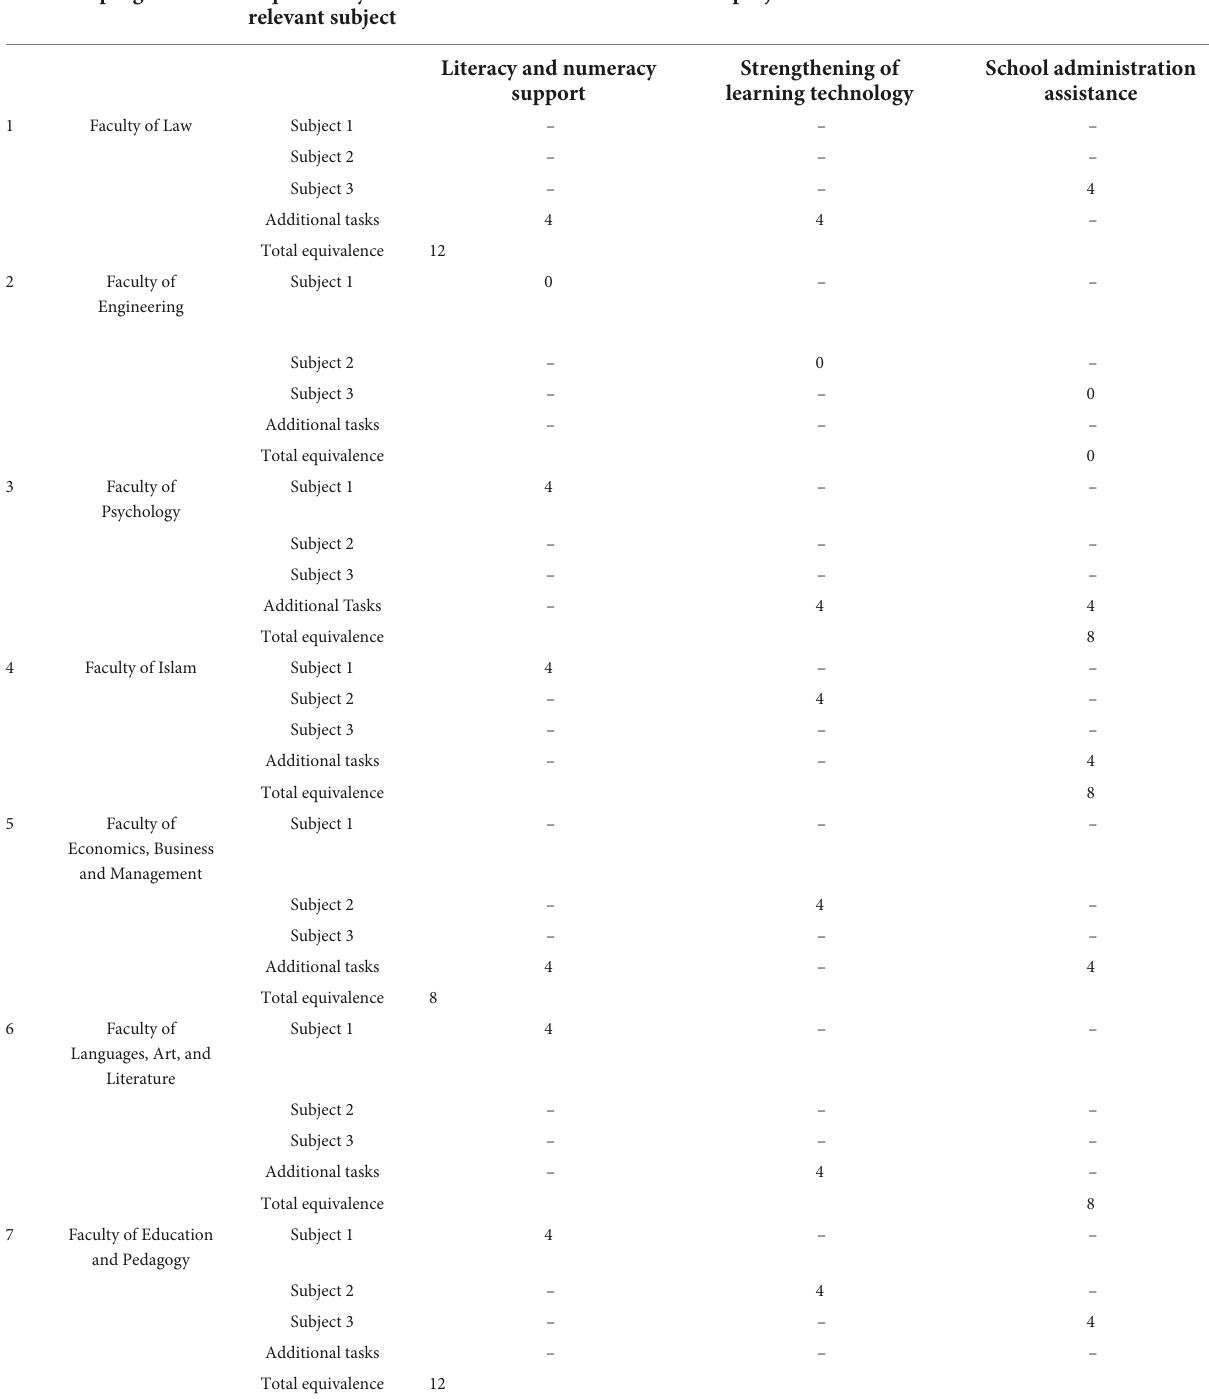
TABLE 3 Activity credit transfer in the teaching campus to relevant